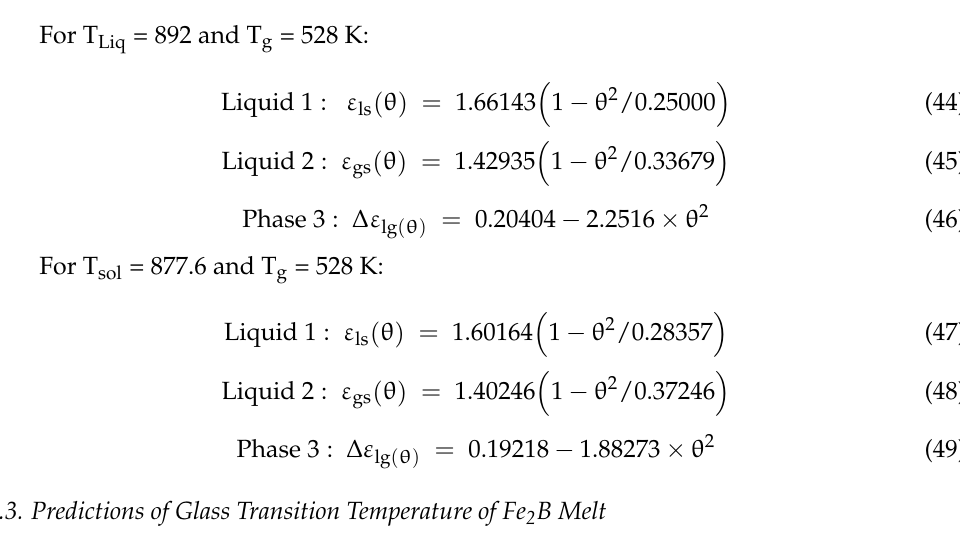
Figure 17. La 50 Al 35 Ni15 enthalpy coefficients of liquidus and solidus melts. T sol = 877.6 K; T n+ = 1013 K; T liq = 892 K; T n+ = T LL = 1033 K. The enthalpy coefficients of ultrastable phase 3 are (−0.19918) for